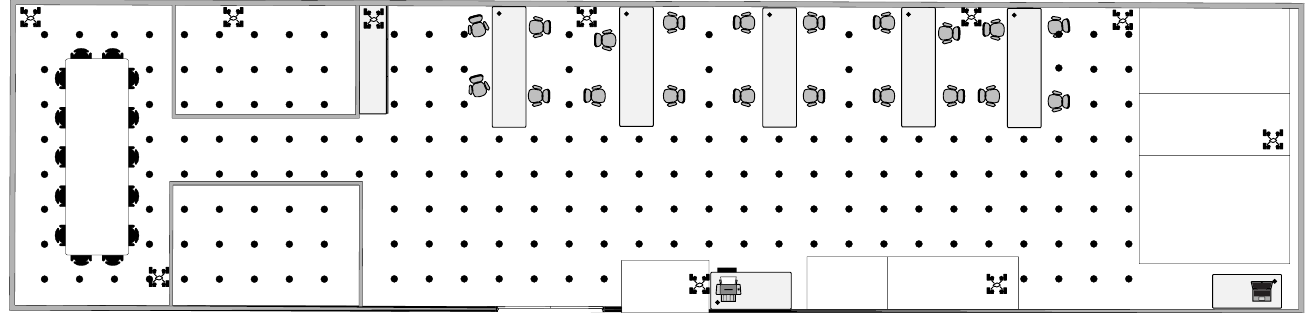
Figure 2. Layout of the experiment area (the dots represent the locations of all reference points).